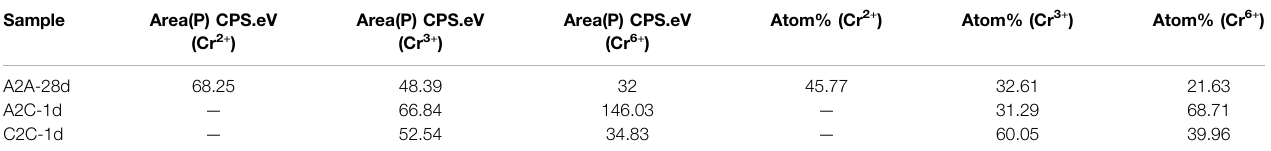
TABLE 4 | XPS fi tting analysis of valence of Cr ions at A2A-28d, A2C-1d, and C2C-1d samples. Sample